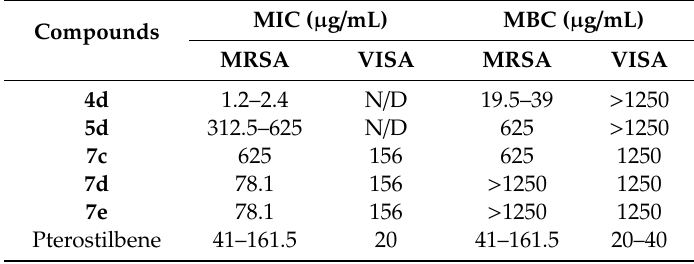
Table 2. The minimum inhibitory concentration (MIC) and minimum bactericidal concentration (MBC) values of MRSA and VISA after treatment with di ff erent